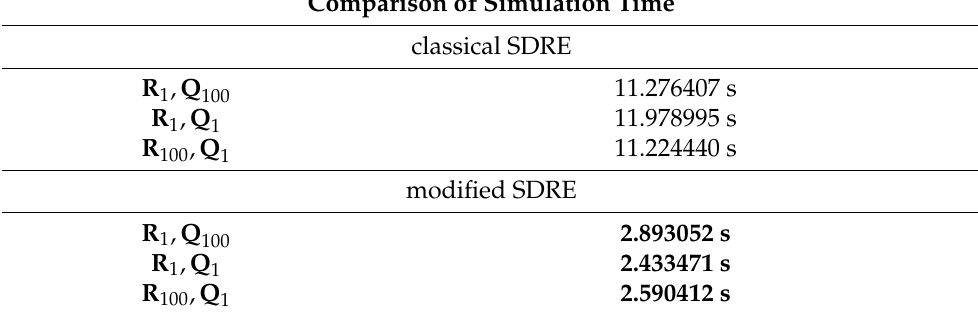
Table 2. Simulation time. Comparison of Simulation